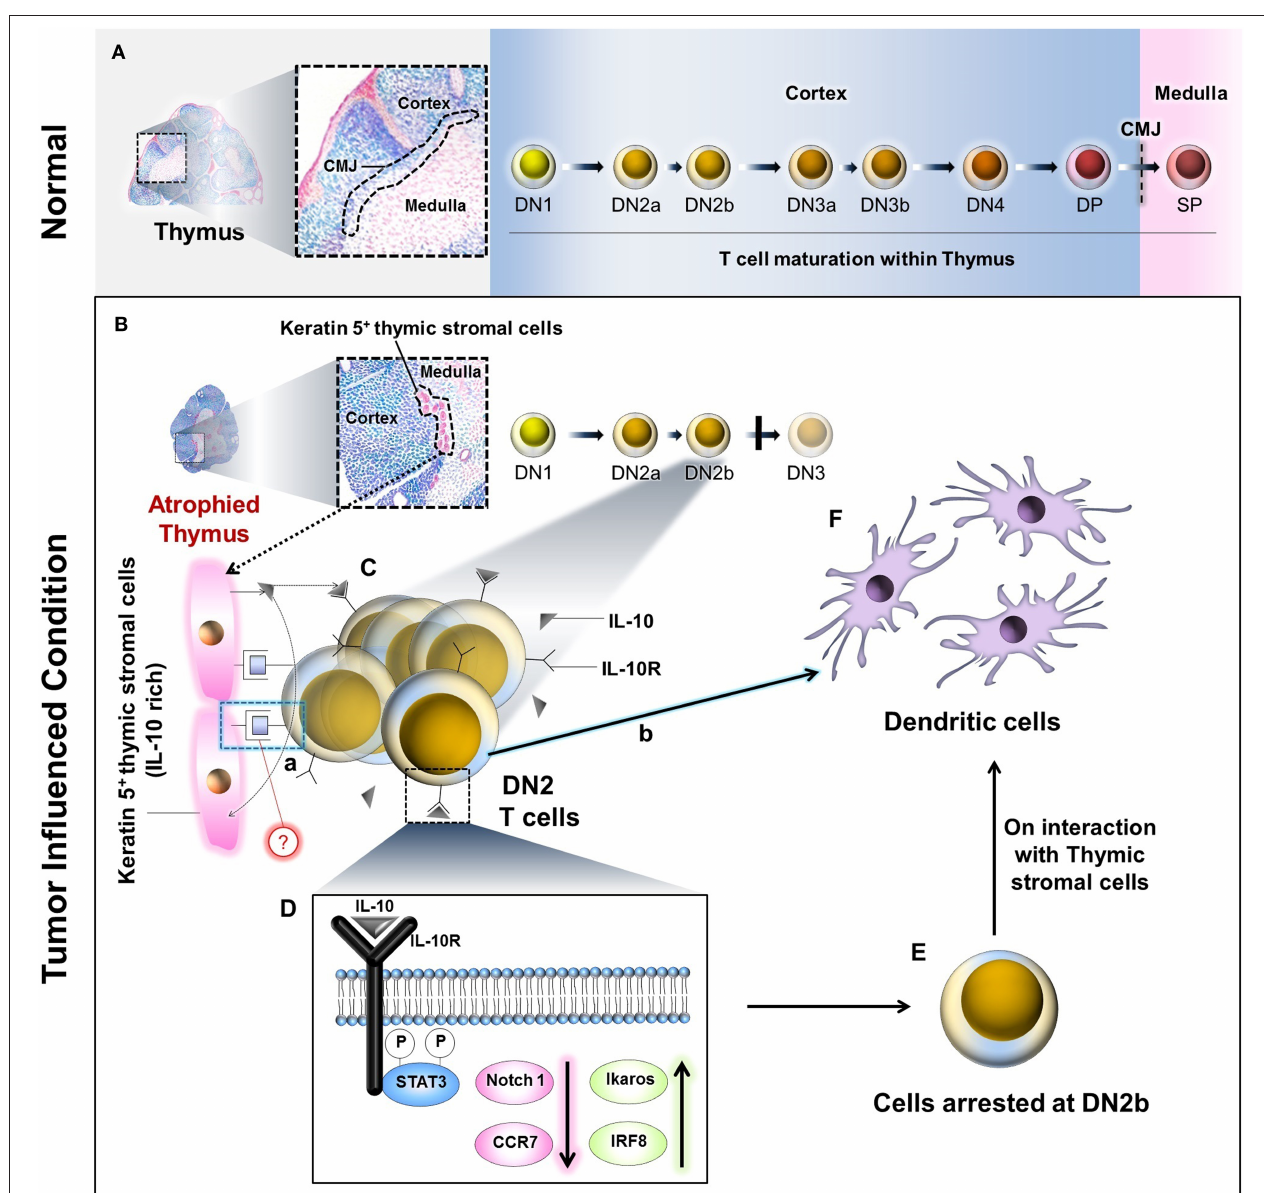
FIGURE 8 | Schematic diagram and probable mechanism of arrest of DN2 pro-T cell-to-DN3 transition and promotion of its conversion to thymic dendritic cells by reciprocal regulation of Ikaros/Notch1 signaling: (A) During maturation, the T lymphocytes progress through the DN1, DN2a, DN2b, DN3a, DN3b, and DN4 to DP stages within the thymic cortex. These DP cells pass the cortico-medullary junction (CMJ) to enter the medulla as they further mature to SP (DN, Double negative; DP, Double positive; SP, Single positive). (B) Under the influence of tumor, thymus becomes atrophied, and Keratin-5 expressing IL-10-rich stromal cells tend to accumulate at the CMJ. (C) IL-10 molecules secreted from these cells interact with DN2b T cells via IL-10 receptors (IL-10R). (D) However, following IL-10–IL-10R interaction(s), STAT3-mediated intracellular signaling events occur within the DN2T cells, which ultimately bring down Notch1 expression. As a consequence, the T cells are arrested at the DN2b stage. (E) Other than Notch1, downregulation of CCR7 and upregulation of Ikaros and IRF8 has also been observed due to these signaling events. A few of these arrested DN2b T cells somehow interact physically with the Keratin 5 + thymic stromal cells at the CMJ (C.a ) and differentiate into dendritic cells (C.b, F ) instead of staying at DN2b or progressing to DN3. The precise mode of the physical interaction(s) between the DN2b T cells and the Keratin-5 + stromal cells (C.a) is yet to be elucidated.